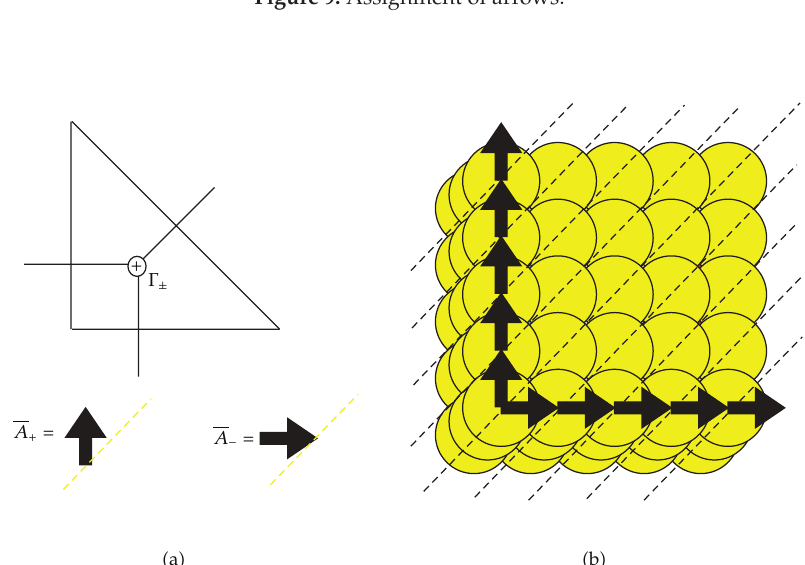
Figure 10: Toric diagram for C 3 (cid:4) a (cid:5) consists of one ⊕ vertex. Operators A ± involve a single Γ ± and have a simple arrow (cid:4) lower part of (cid:4) a (cid:5)(cid:5) , as follows from Figure 9. The correlator (cid:4) 4.1 (cid:5) is translated into a sequence of arrows, with rotated dashed lines representing insertions of interlacing two-dimensional partitions. The resulting figure (cid:4) b (cid:5) represents plane partitions crystal model, the same as in Figure 7, but now seen from the